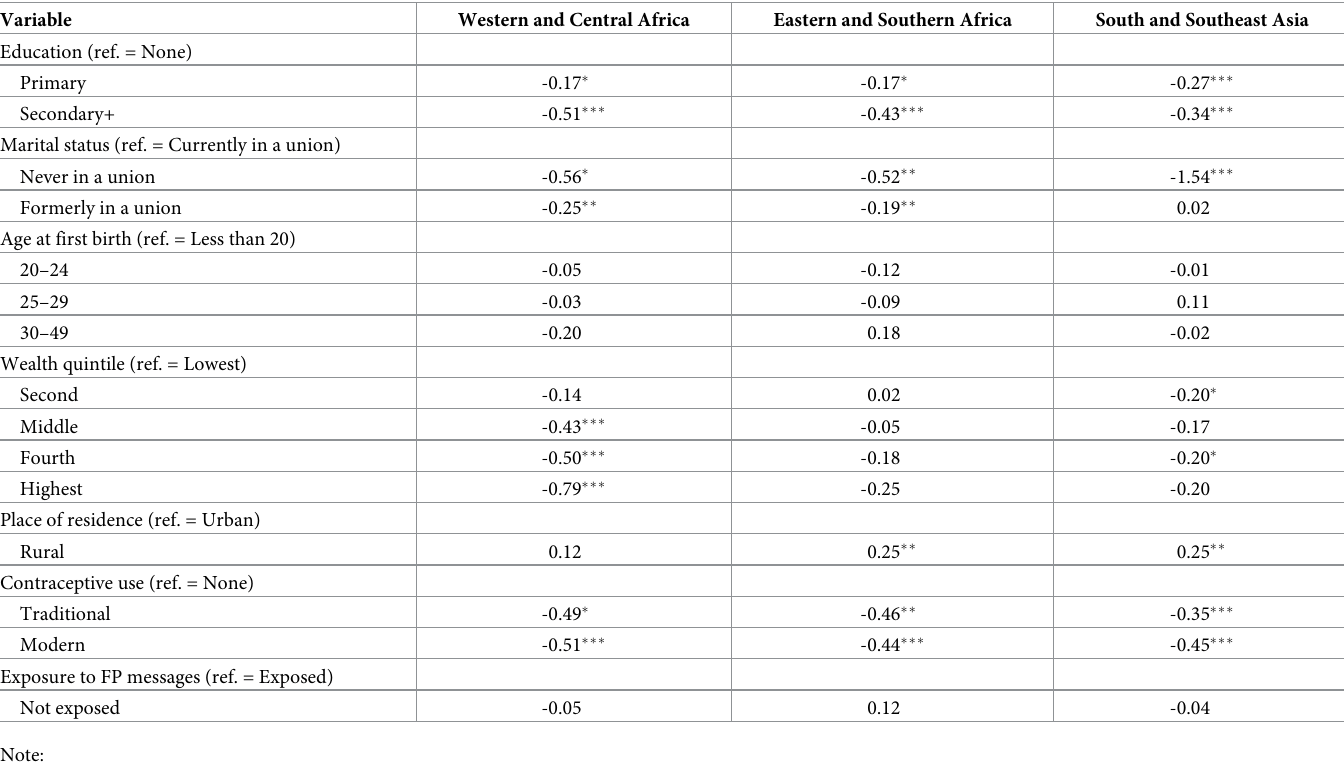
Table 4. Adjusted coefficients of the control variables in Model 1 from the logistic regressions of unrealized